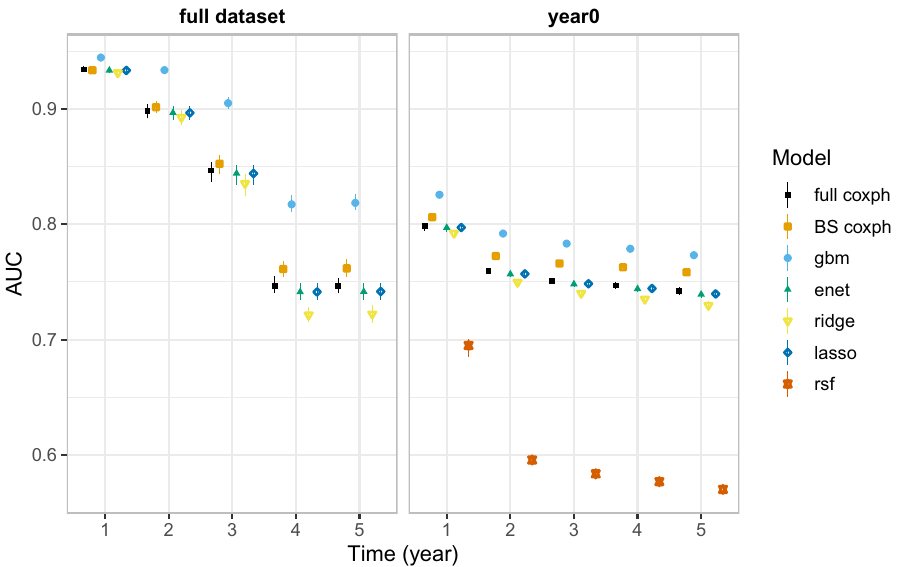
Figure 2. Time-dependent AUC scores evaluated at different time points. The scores are based on 200 bootstrapped samples (50 for rsf due to computational limitations) of the test data. Models with higher scores and narrower confidence intervals are better performers. As with the concordance index, models do better with the fully time-varying covariates (full), and gbm does better than other